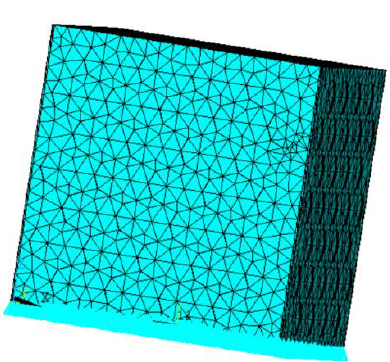
Figure 13. Meshing of perforated steel plate reinforced concrete.